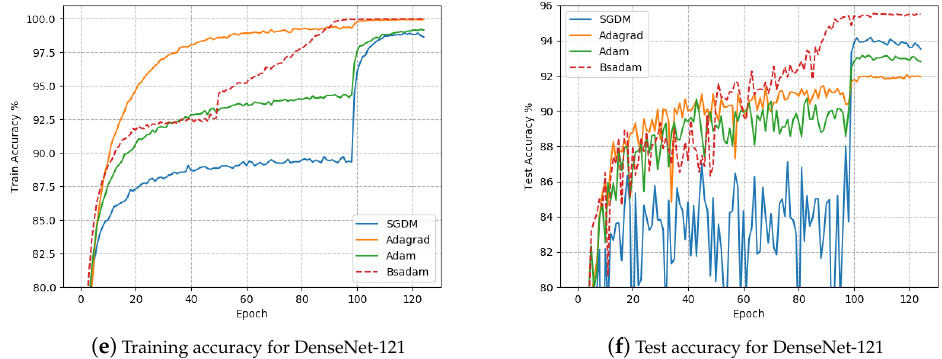
Figure 4. Training and test accuracy for ResNet-34, SENet-34 and DenseNet-121 on CIFAR-10.